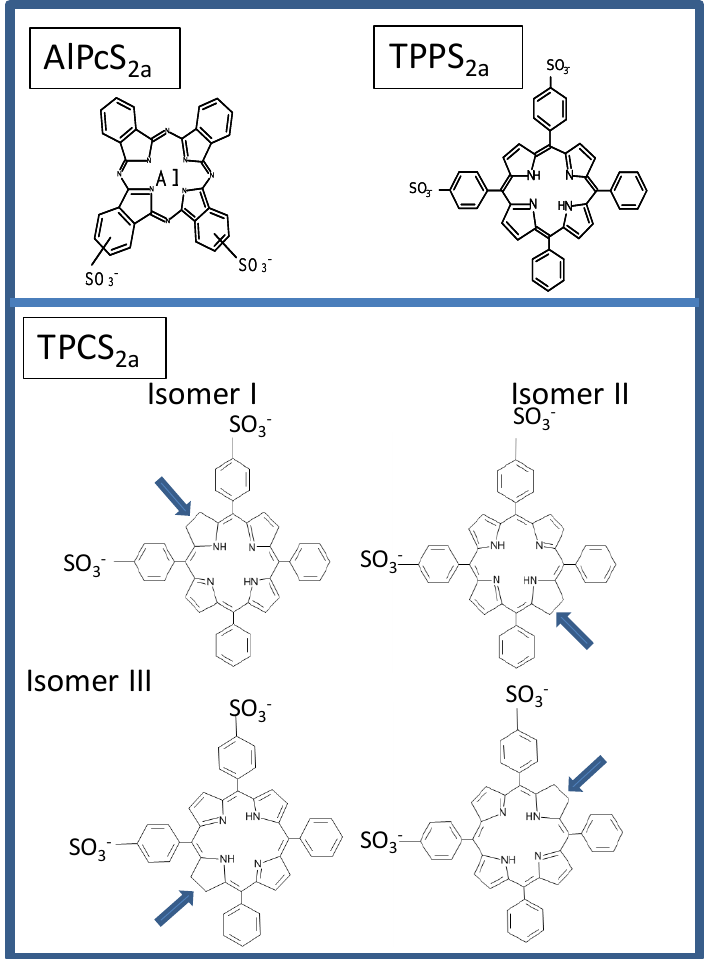
Figure 1. Main photosensitizers used in PCI. The reduced double bonds in the pyrrols of TPCS 2a are indicated. The TPCS 2a isomers are formed in approx. the ratio of 1:1:2 for the isomers I, II and III since isomer III can be formed by reduction of two pyrrole groups [51].